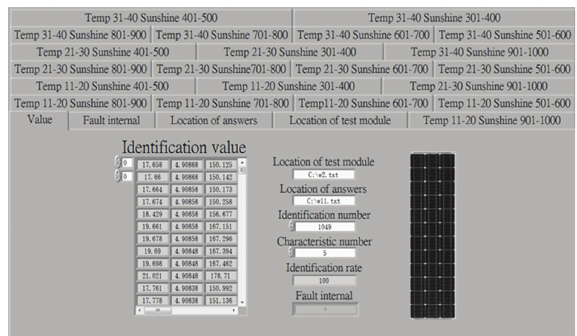
Figure 10: The fault diagnosis system of the solar power system.